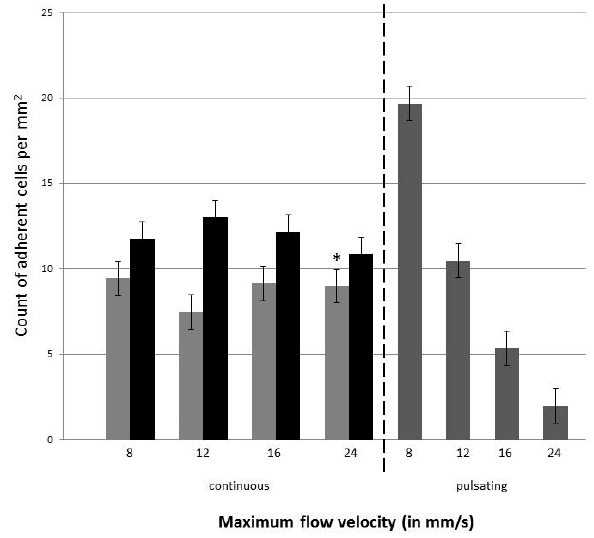
Figure 7. Number of H838GFP and SK-Mel 28GFP tumor cells adherent to the endothelial monolayer within the vessel equivalent. Light grey bars show the count for H838GFP, black bars the count of SK-Mel 298GFP for continuous flow, dark grey bars represent the number of H838GFP cells adherent to the endothelial cells when perfused with pulsatile flow. Four different flow velocities of 8, 12, 16, and 24 mm/s were used in both the continuous and pulsatile flow. Pulsation rate was 60/min. Endothelial cells were incubated with a medium for 30 min before the tumor cells were introduced. Tumor cell suspension was infused for 6 h. The mean value represents the average number of adherent cells in five different areas of 2 mm length in the microfluidic channel (top of the channel and membrane). The standard deviation is taken over the number of microfluidic devices used for the measurements. Dark grey bars and *: three devices were analyzed; light grey and black bars: 2 devices were